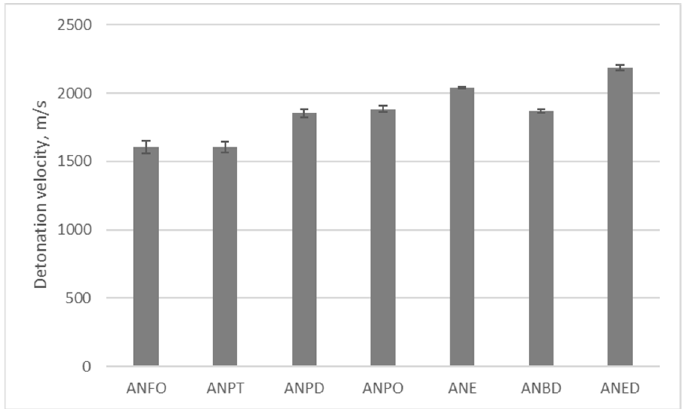
Figure 4. The dependence of the detonation velocity of ammonium nitrate-based explosives on the type of alcohol added.